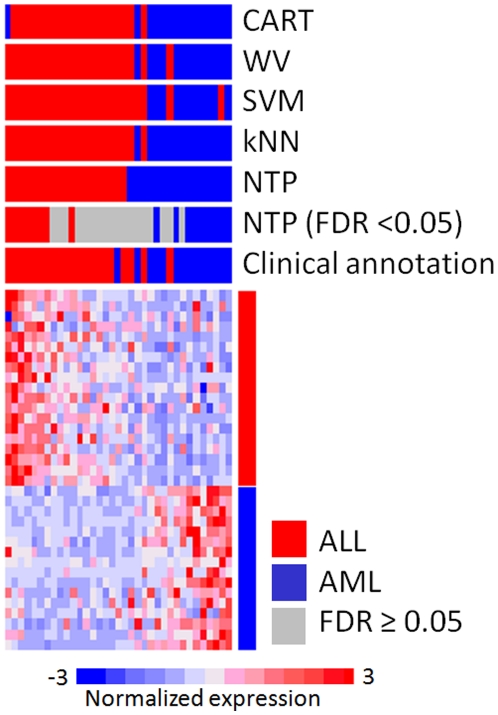
Example 1: Prediction of acute lymphoblastic leukemia (ALL) and acute myeloid leukemia (AML).Previously reported ALL-AML signature was evaluated on the test set (N = 35) employed in the study. Samples are ordered according to proximity to either of the template of ALL or AML to visualize clear or unclear expression pattern of the signature genes in each sample. Note that closer distance to template (i.e., most left or right in heatmap) does not necessarily indicate higher prediction confidence because the confidence p-value is calculated based on null distribution for the distance generated for each individual sample. CART: classification and regression tree, WV: weighted voting, SVM: support vector machine, kNN: k-nearest neighbor, FDR: false discovery rate.